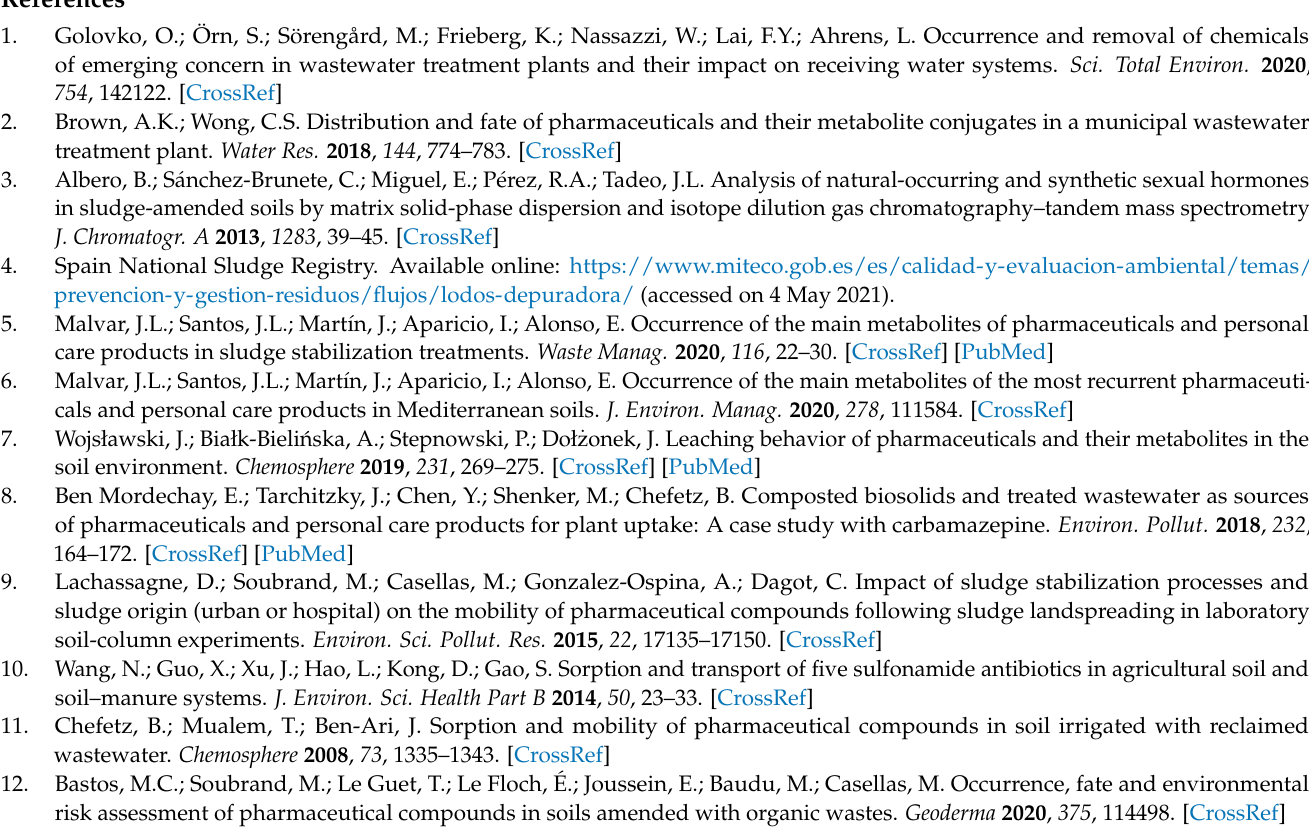
Supplementary Materials: Figure S1: Correlations between log K d and log K ow for CBZ and its metabolites in sewage sludge (top) and soil mixtures (bottom) ( n = 42), Table S1: LC-MS/MS parameters, Table S2: Accuracy (%), precision, expressed as the relative standard deviation (%), extraction recovery, method detection limits (MDL), method quantitation limits (MQL) and the matrix effect, Table S3: Efficiency of the spike procedure of PhCs and their metabolites in sludge and compost, Table S4: Concentration of PhCs and metabolites measured in solid (C s ) and aqueous (C aq ) samples in the batch